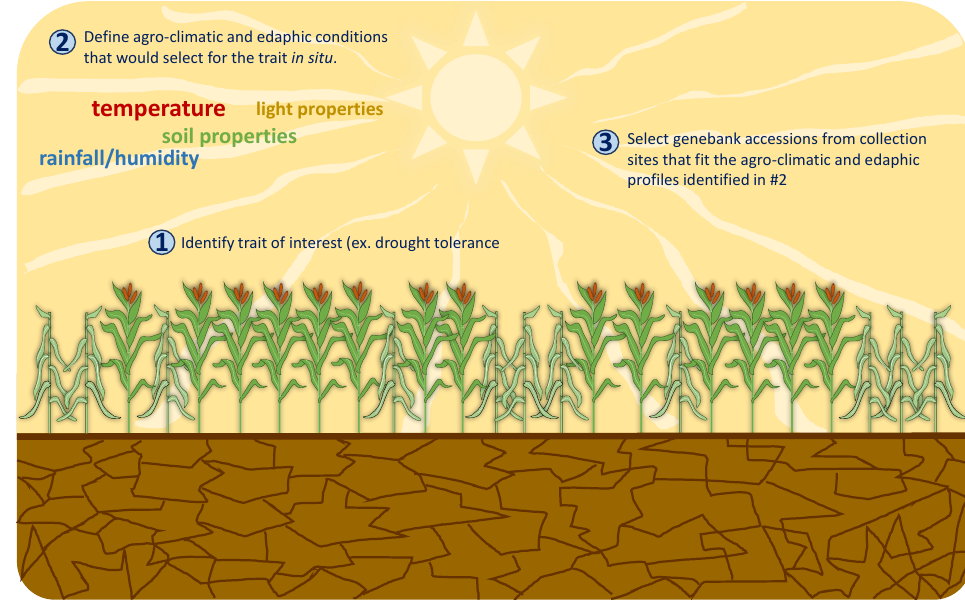
Figure 1. Basic FIGS search for germplasm having trait of interest. Following the identification of a trait of interest, i.e., drought tolerance, the agro-climatic and edaphic conditions under which plants are most likely to develop the trait of interest are profiled. Gene bank collections are then mined for accessions that were collected from locations with environmental profiles that fit the conditions identified to select for the trait in situ. The selected subset of best-bet accessions will be screened for drought